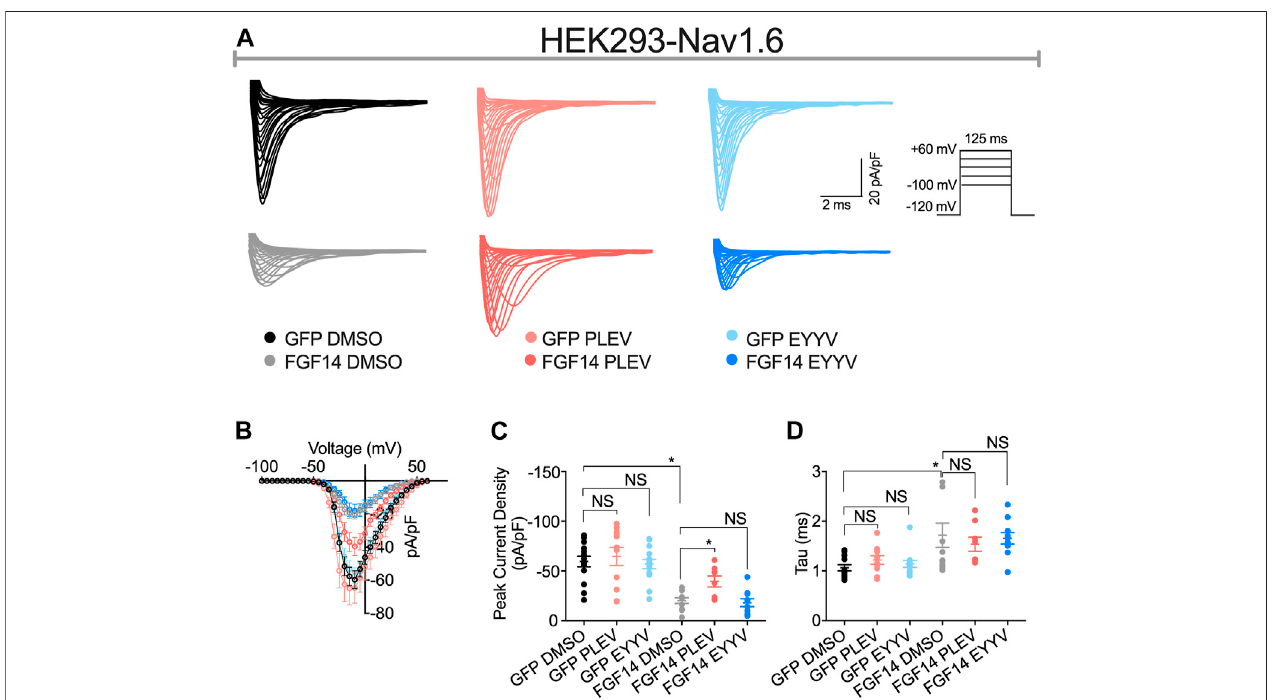
FIGURE3| PLEVandEYYVdifferentiallymodulatepeaktransientINadensityinthepresenceofFGF14. (A) RepresentativetracesoftransientNa+currentselicited by HEK293-Nav1.6 cells co-expressing either GFP of FGF14-GFP that had been treated with 0.1% DMSO, 50 µM PLEV, or 50 µM EYYV in response to voltage-steps from − 100 mV to +60 mV from a holding potential of – 70 mV (inset). (B) Current-voltage relationships for experimental groups described in (A). (C,D) Comparison of peak transient INa density (C) and tau ( τ ) of fast inactivation (D) for the indicated experimental groups. Data are mean ± SEM. Signi fi cance was assessed using a one-way ANOVA Tukey ’ s multiple comparisons test. NS (cid:2) non-signi fi cant; *, p at least < 0.05 (detailed p values and summary of results are reported in Table 1